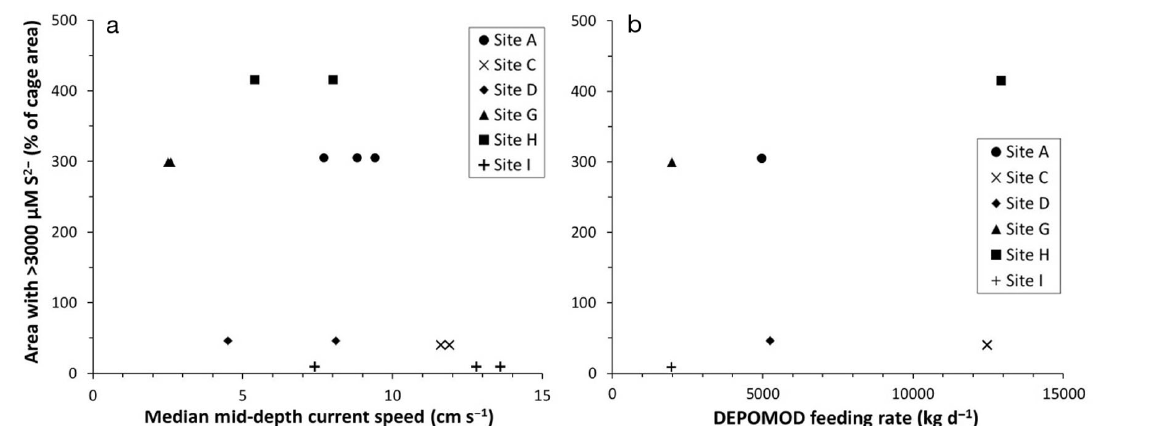
Fig. 6. Relationships between the seafloor area with elevated sulfide concentrations (>3000 µM S 2− ) and (left) the median mid- depth current speed and (right) the average daily feeding rate per site during 1 mo periods including the sediment sampling date. Areas are normalized relative to the total surface area of cages at each site